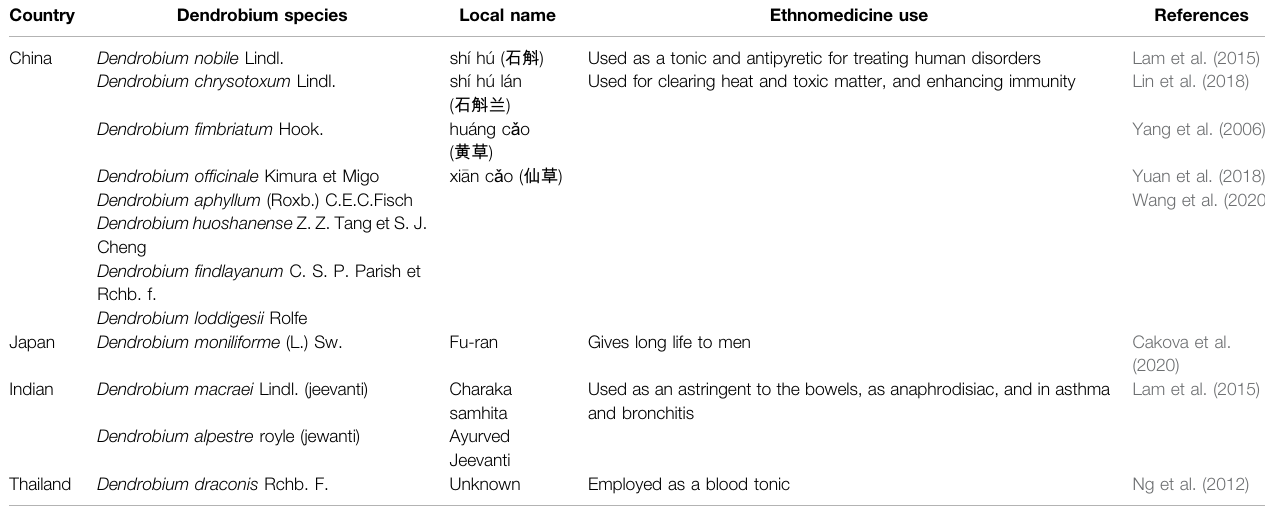
TABLE 1 | The ethnomedicine use of Dendrobium in some